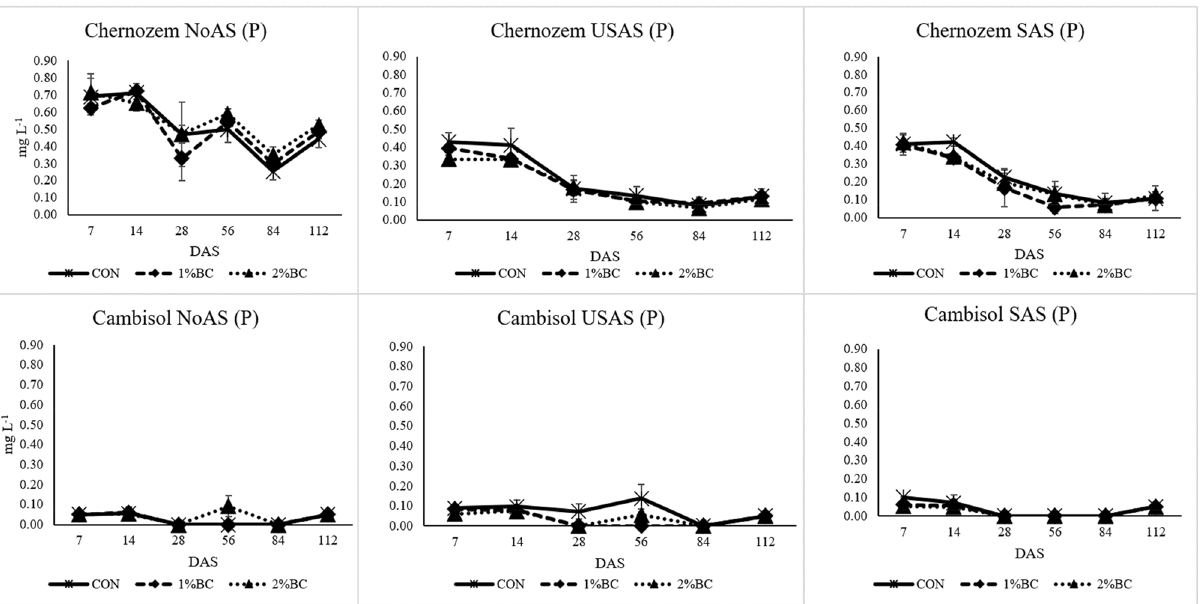
Figure 6. The effect of biochar, USAS (un-stabilized ammonium sulphate) and SAS (stabilized ammonium sulphate with DMPP) on the concentration of P (mg L −1 ) in soil solution. NoAS No ammonium sulphate, CON control, 1%BC 1% biochar, 2%BC 2% biochar, DAS day after